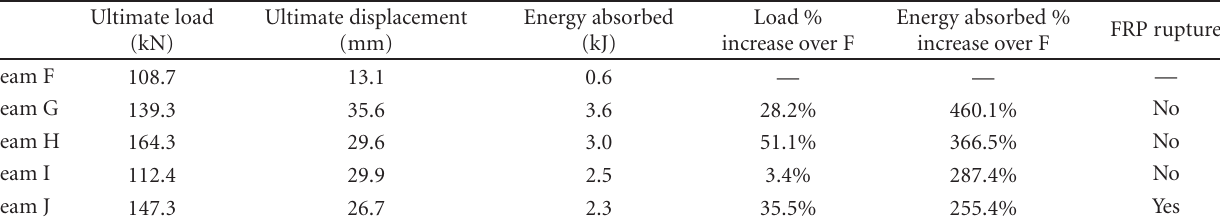
Table 3: Summary of results: